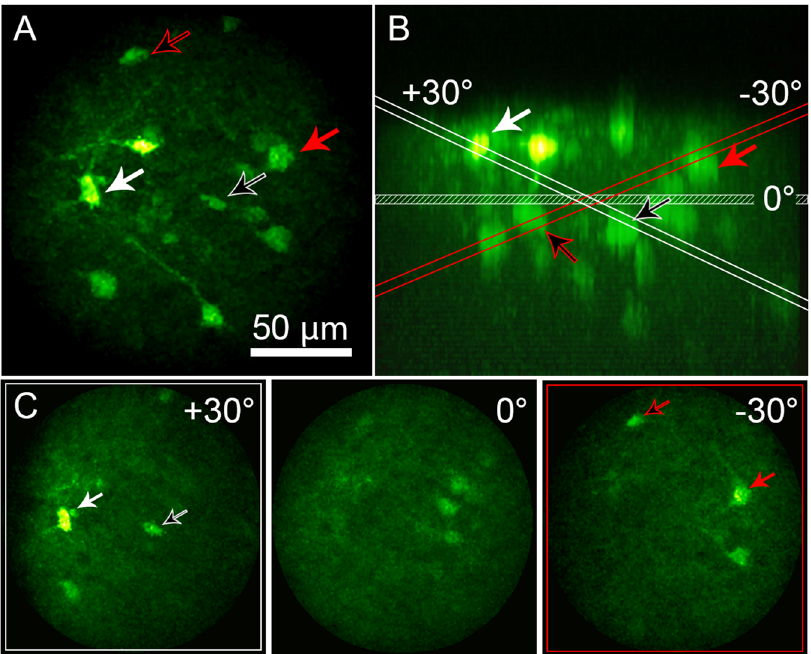
Figure 4. Tilted-field scan enabled by rapid focusing of the EWTL lens. ( A ) Maximum intensity projection of a thick coronal section of mouse brain, expressing GCaMP6s in neurons, acquired by the 2P-FCM. Arrows indicate cell bodies that are visible during tilted-field scanning. ( B ) Side (XZ) projection of the image volume in A. The same cell bodies are indicated by the arrows. The planes for the horizontal and angled scan limits are indicated and color coded red for the − 30 degrees scan, and white for the + 30 degrees scan. ( C ) Images showing the tilted-field scans, indicating the same cell bodies that are shown to intersect with the red or white planes in B.